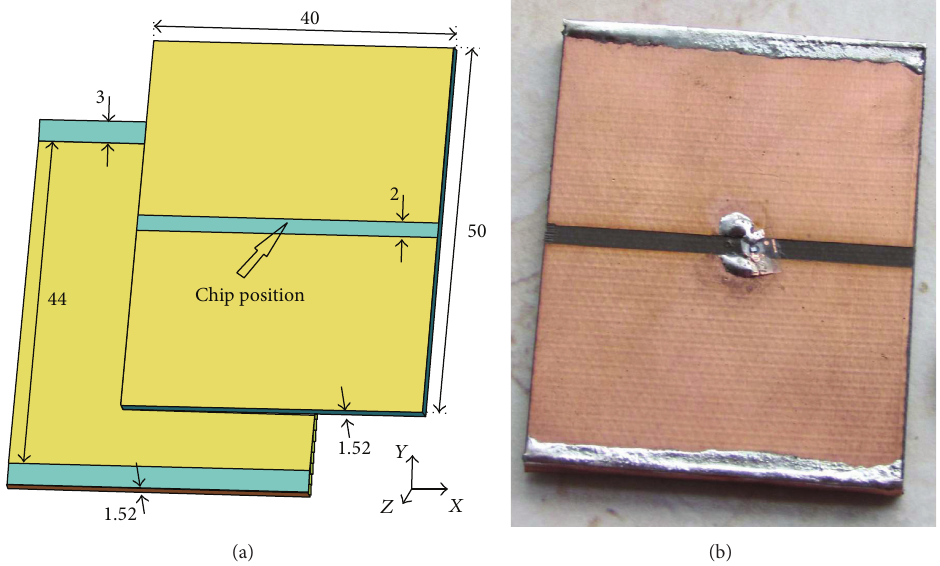
Figure 2: Sketch (a) and photograph (b) of folded coupled patches RFID antenna (dimensions stated in